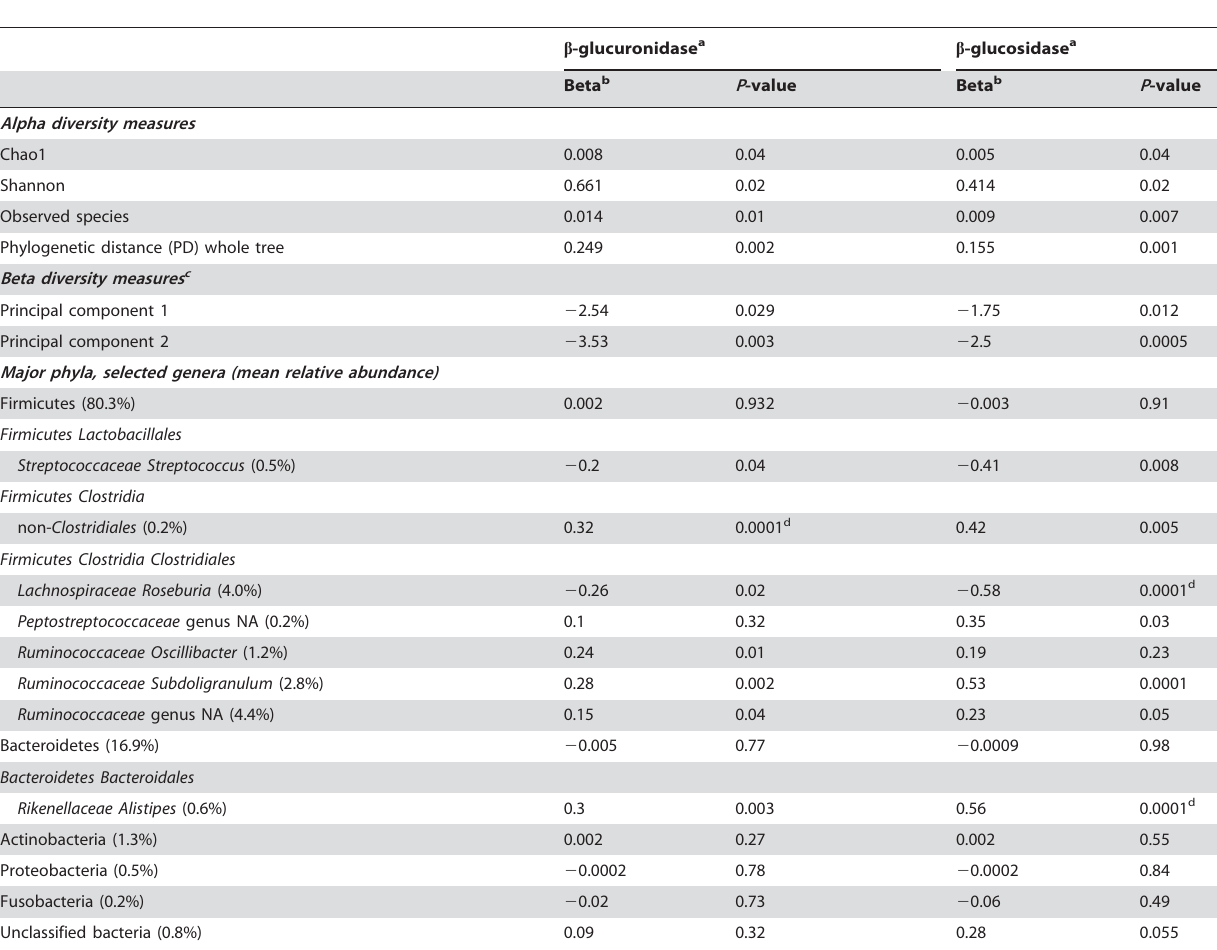
Table 2. Associations of alpha diversity measures and of major bacterial taxa and selected genera with levels of microbial enzymatic